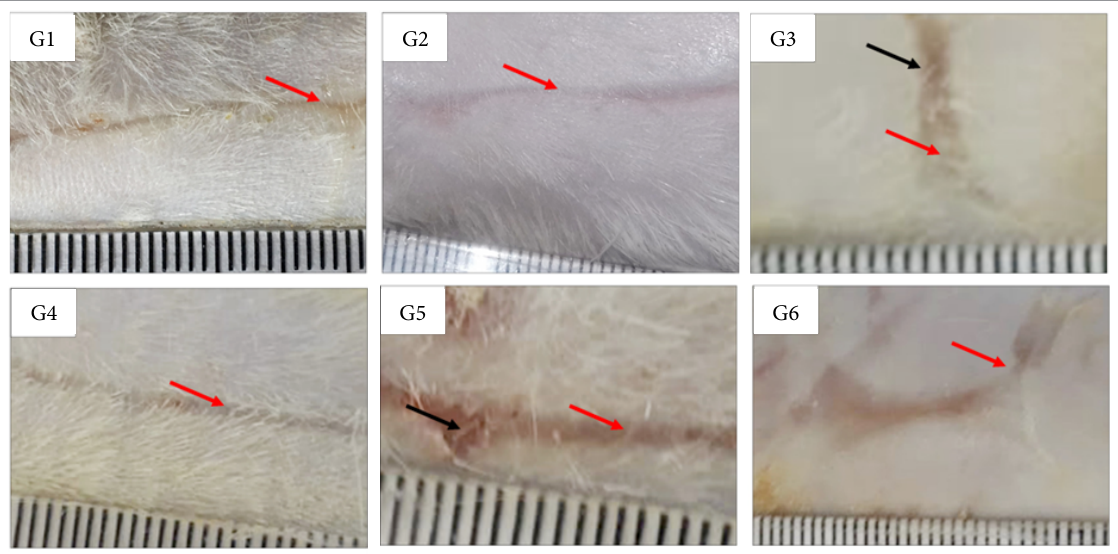
Figure 2 - Macroscopic aspects of partial thickness burn wounds experimentally induced in Wistar rats 14 days after the injury induction. Scale in mm.